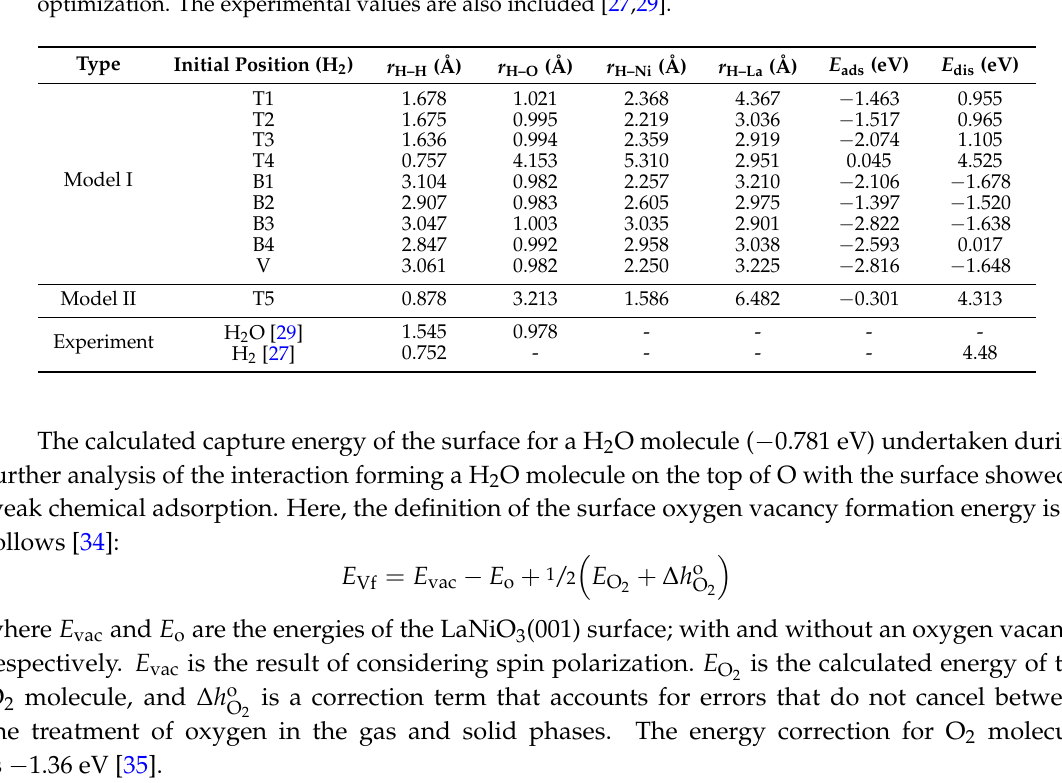
Table 2. The calculated geometry and energy parameters of LaNiO 3 (001)/H 2 after geometry optimization. The experimental values are also included [27,29].